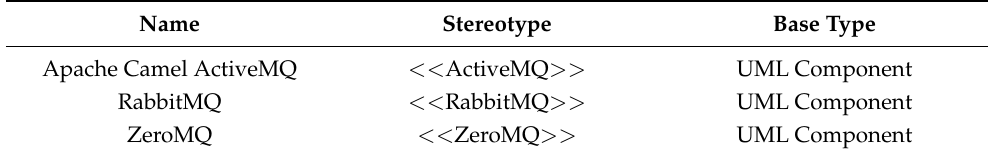
Table 4. Stereotypes for message queues.